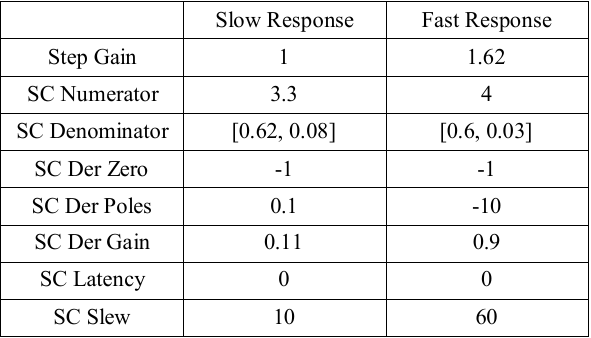
Table 5. Parameters used in dual-mode model to generate a 4  simulation response